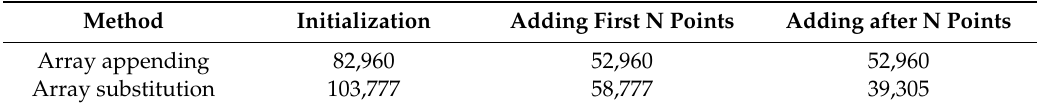
Table 1. Average gas consumption of storage